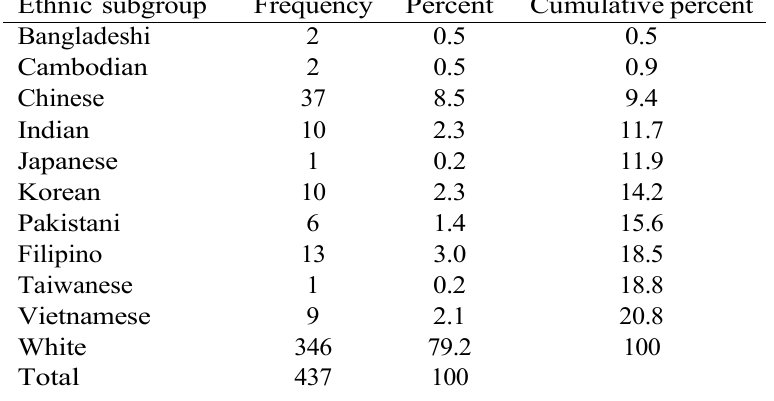
Table 1: Ethnic breakdown of Asians and Whites.